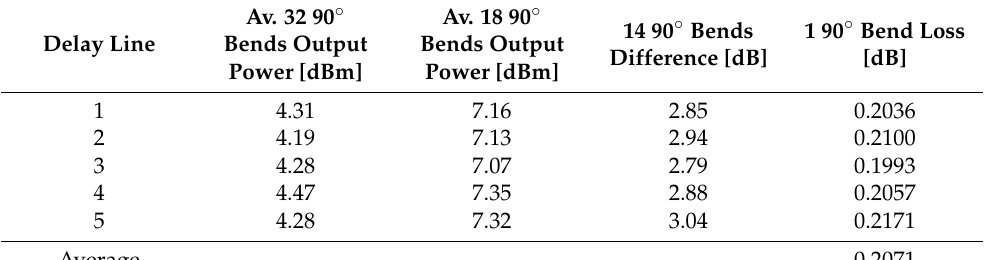
Table 4. Summary of results for bend WG loss, W × H = 1000 × 320 nm, λ = 660